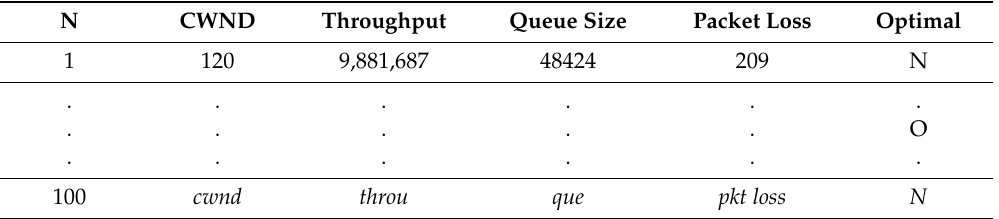
100 cwnd throu que pkt loss